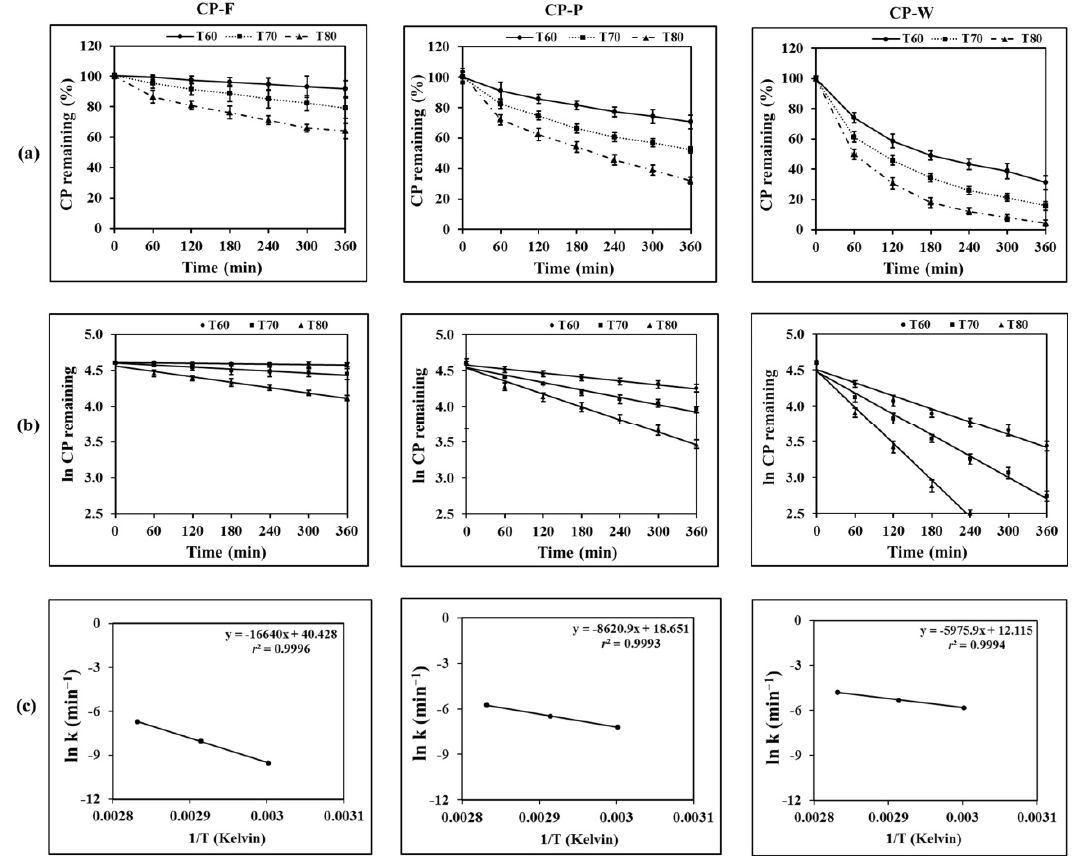
Figure 2. Degradation profiles of CP under heat exposure, ( a ) zero order plots, ( b ) first order plots, and ( c ) Arrhenius plots. Table 1. The r 2 values of a linear regression from zero and first order plots of carbamide peroxide (CP) degradation by heat exposure.